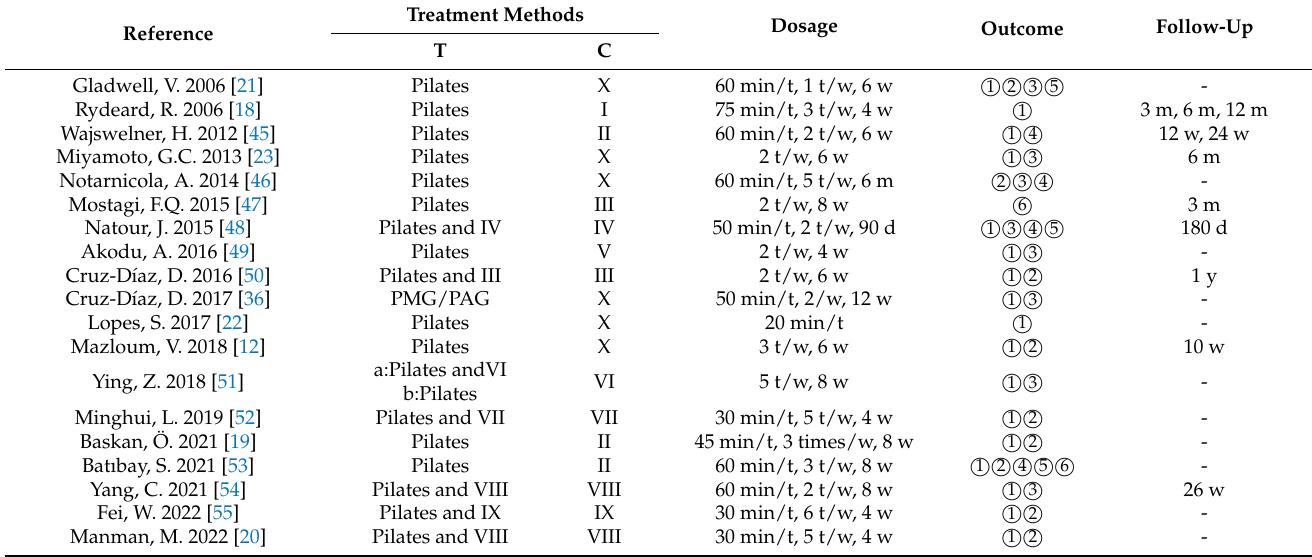
Table 2. The details of research intervention and outcome indicators.